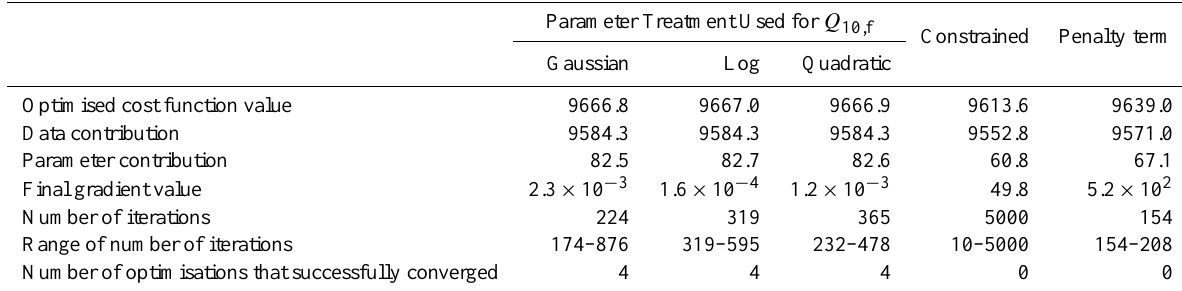
Table 2. Values of the cost function, the contributions from data and parameters, the gradient, the number of iterations to achieve convergence and how many optimisations from the ensemble of five converged to this value for the different parameter transformations of Q 10,f and the constrained and penalty term